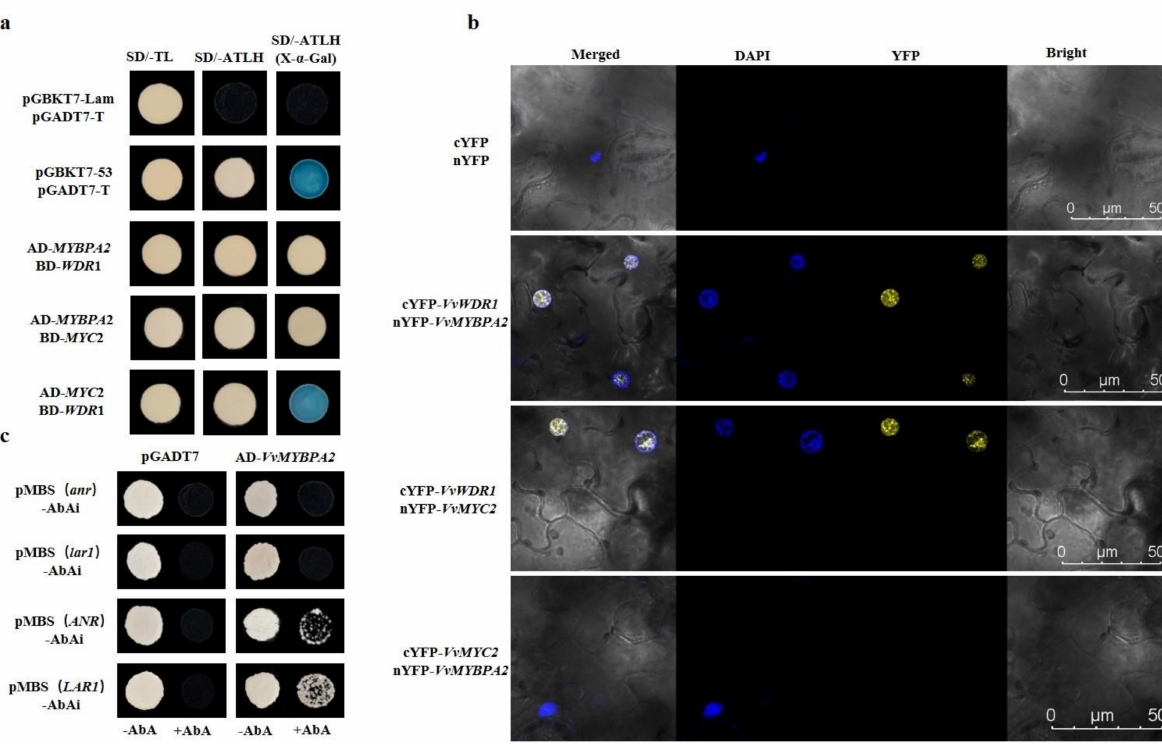
Figure 4. Interaction between VvMYBPA2 and PAs biosynthesis-related genes. ( a ) Y2H assay analyzed the interaction among MYBPA2, WDR1 and MYC2 in vitro. ( b ) The interaction of VvMYBPA2, VvWDR1 and VvMYC2 in tobacco cells was analyzed by BiFC assay. ( c ) The interaction between VvMYBPA2 and the promoters of VvANR and VvLAR1 was analyzed by Y1H